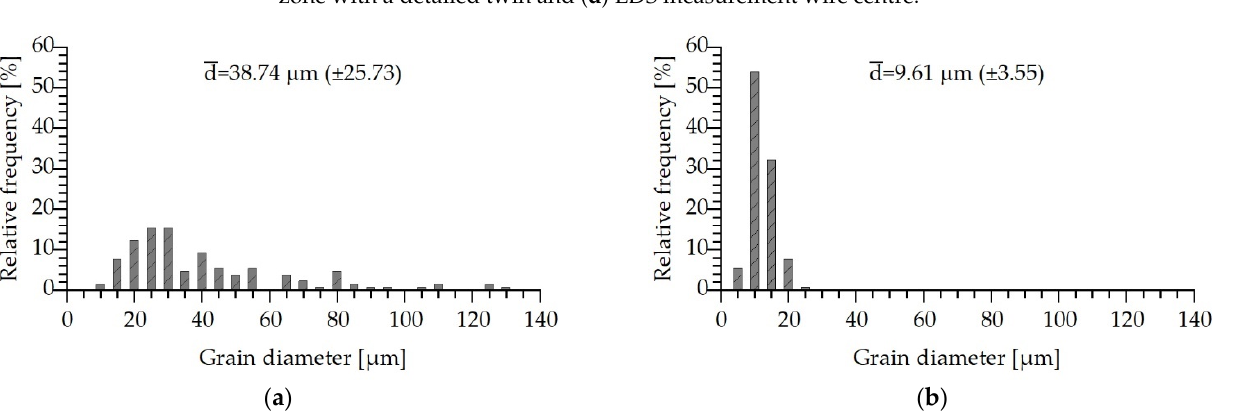
Figure 3. Twin-roll cast initial condition in longitudinal view, ( a ) general view (red arrows show segregations), ( b ) detailed image from the upper edge, from the middle and from the lower edge, red markings and arrows show exemplary precipitates and twins, ( c ) EBSD measurement peripheral zone with a detailed twin and ( d ) EDS measurement wire centre.